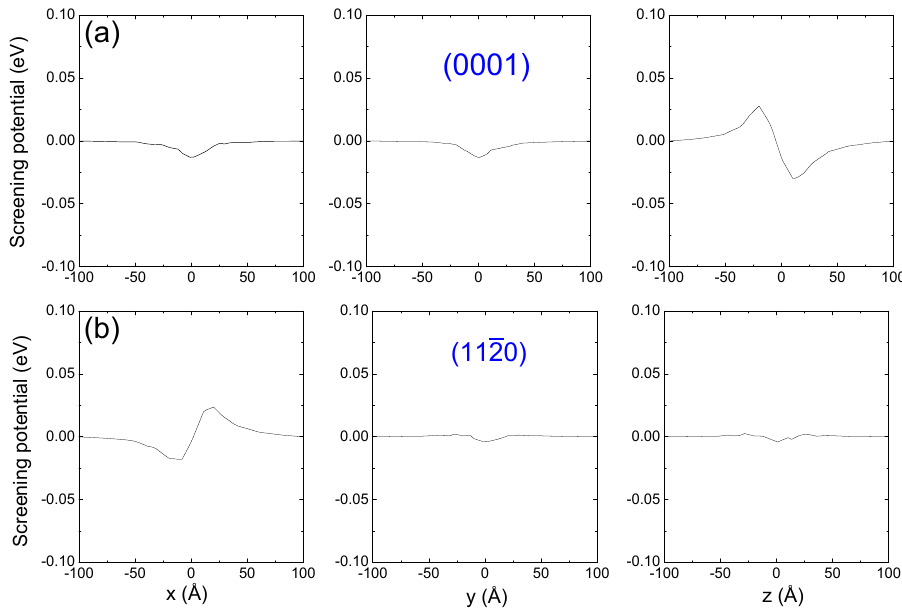
Figure 3. Screening potential φ ( r ) along x -, y -, and z -axes for ( a ) (0001)- and ( b ) (11¯20)-oriented a-plane GaN/AlN QD structures grown on GaN